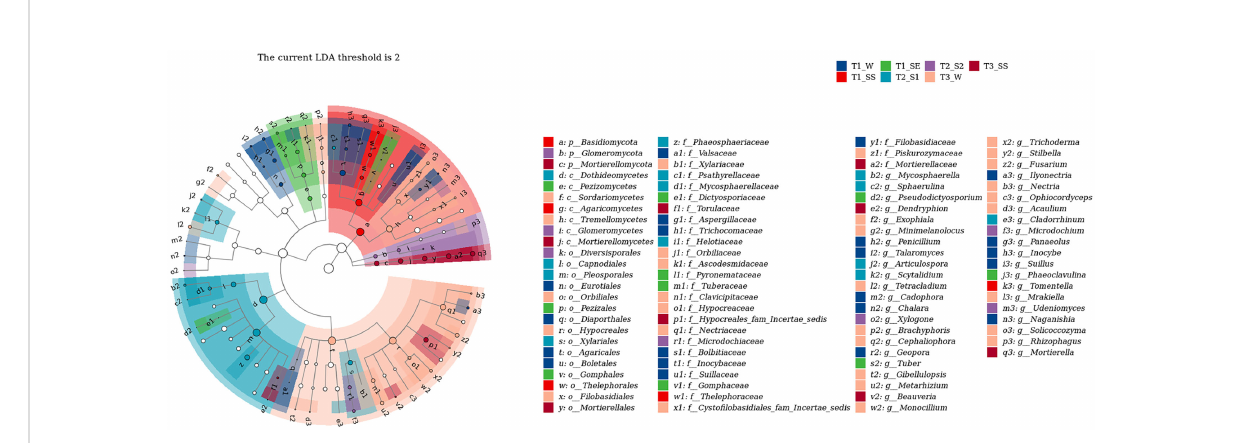
FIGURE 11 Linear discriminant analysis (LDA) effect size (LefSe) for fungi in soils belonging to different water-repellency classes beneath Pinus (T1), Robinia (T2), and Hippophae